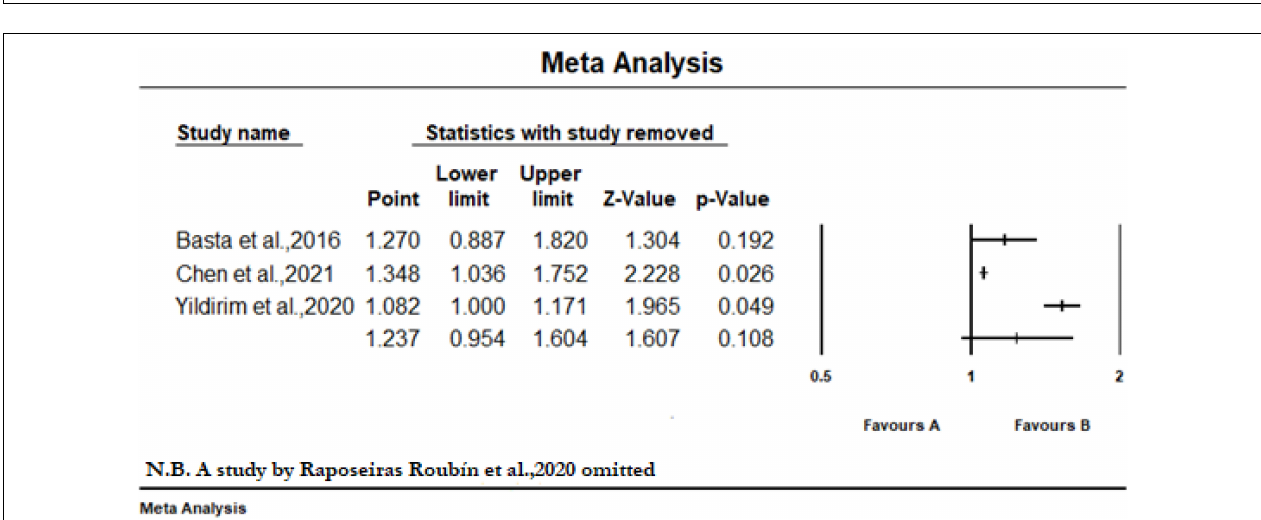
FIGURE 3 | Sensitivity analysis of included studies to determine the pooled hazard ratio with 95% CI of all-cause mortality for per point increase in CONUT score when a study by Raposeiras Roubín et al. (25) was